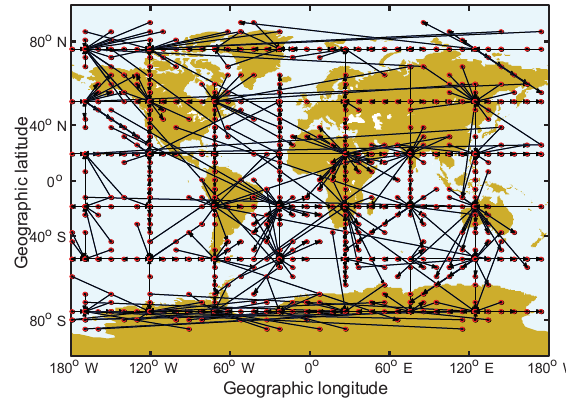
Figure 1. The directed complex network of the ionosphere (in part). The network is developed from the GIM dataset by the FGS algo- rithm. The nodes indicate the GIM cells, while the directed edges represent causal interactions between